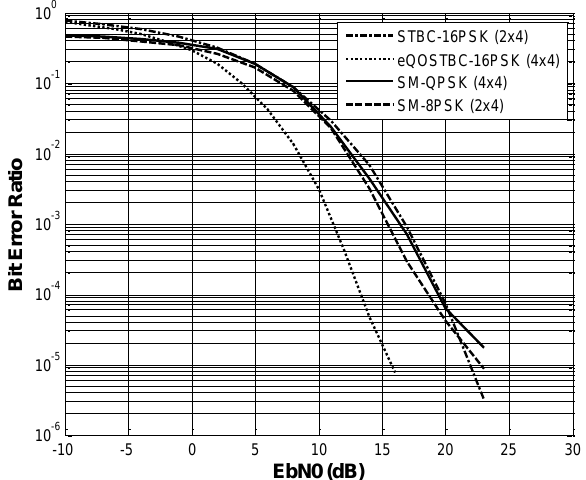
Figure 10: Comparison of four bits transmissions using SM, STBC and QOSTBC